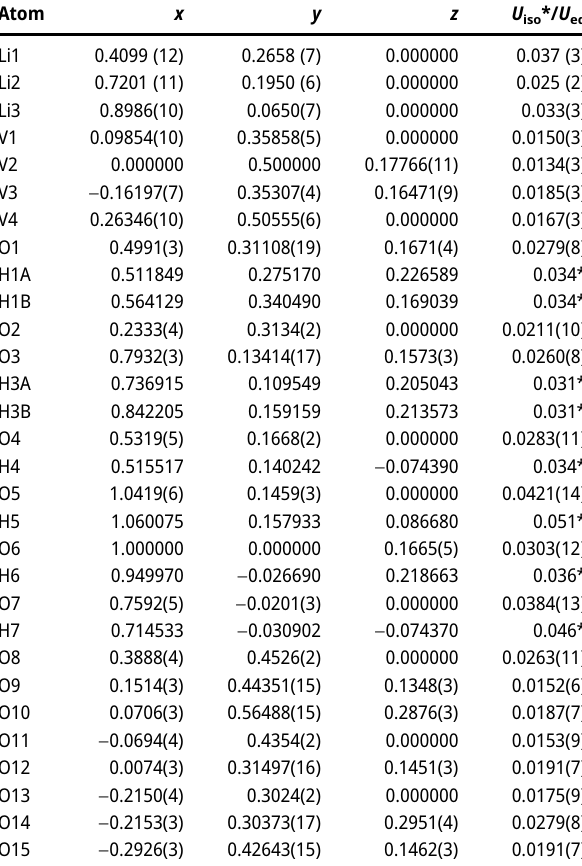
Table  : Fractional atomic coordinates and isotropic or equivalent isotropic displacement parameters (Å 